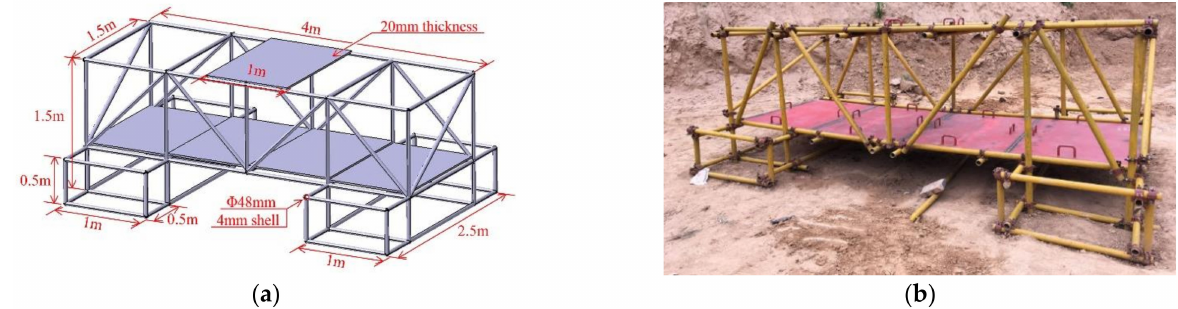
Figure 1. Composite steel structure. ( a ) Three-dimensional size; ( b ) Site